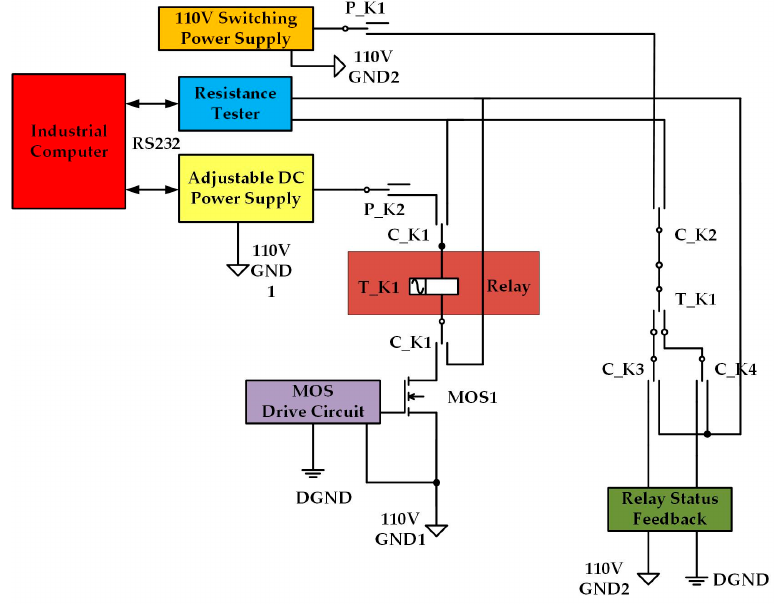
Figure 5. Test method of contact resistance.